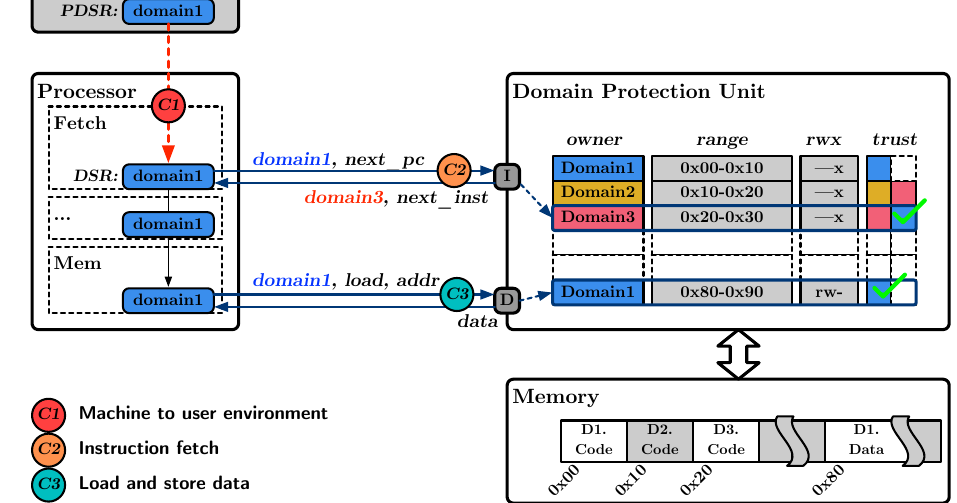
Figure 2. Proposed architecture of Domain-Enforced Memory